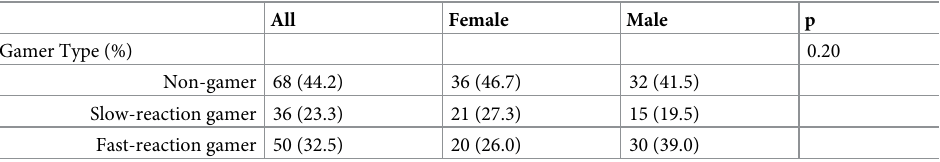
Scores are presented for the entire sample and for male and female participants separately. Fisher’s exact test was